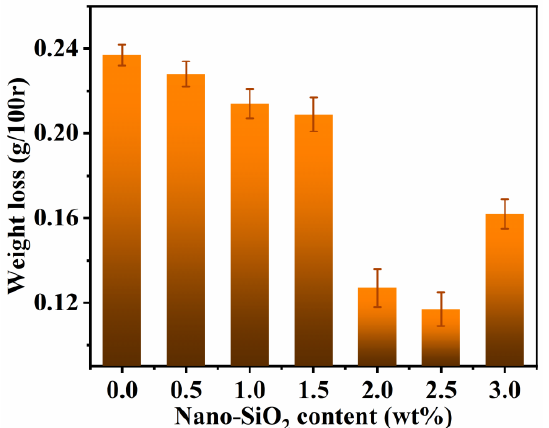
Figure 4. Effect of nano-SiO 2 content on abrasion resistance of WAA paint film.